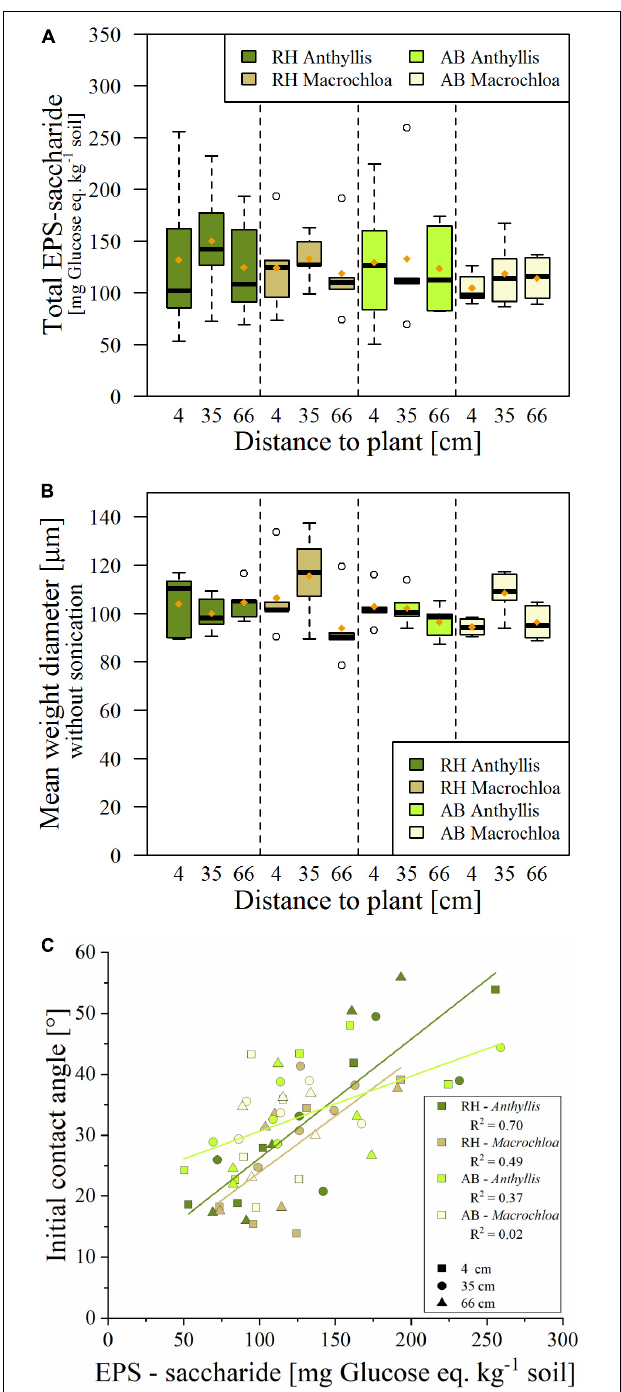
FIGURE 5 | EPS-saccharide content, expressed as glucose equivalent (A) and Mean Weight Diameter (MWD) of the microaggregate fraction ( < 0.25 mm) (B) derived of the soil samples from Alboloduy (AB) and Rambla Honda (RH). Box-and-whisker diagrams showing the median (black line), 25th/75th percentile (resp. upper/lower part box), min./max. (whiskers) and mean values (orange dot), with 5 replicates per box. In subfigure (C) linear regression correlations between EPS-saccharide content and initial contact angle of the microaggregate fraction for the plant/site combinations are